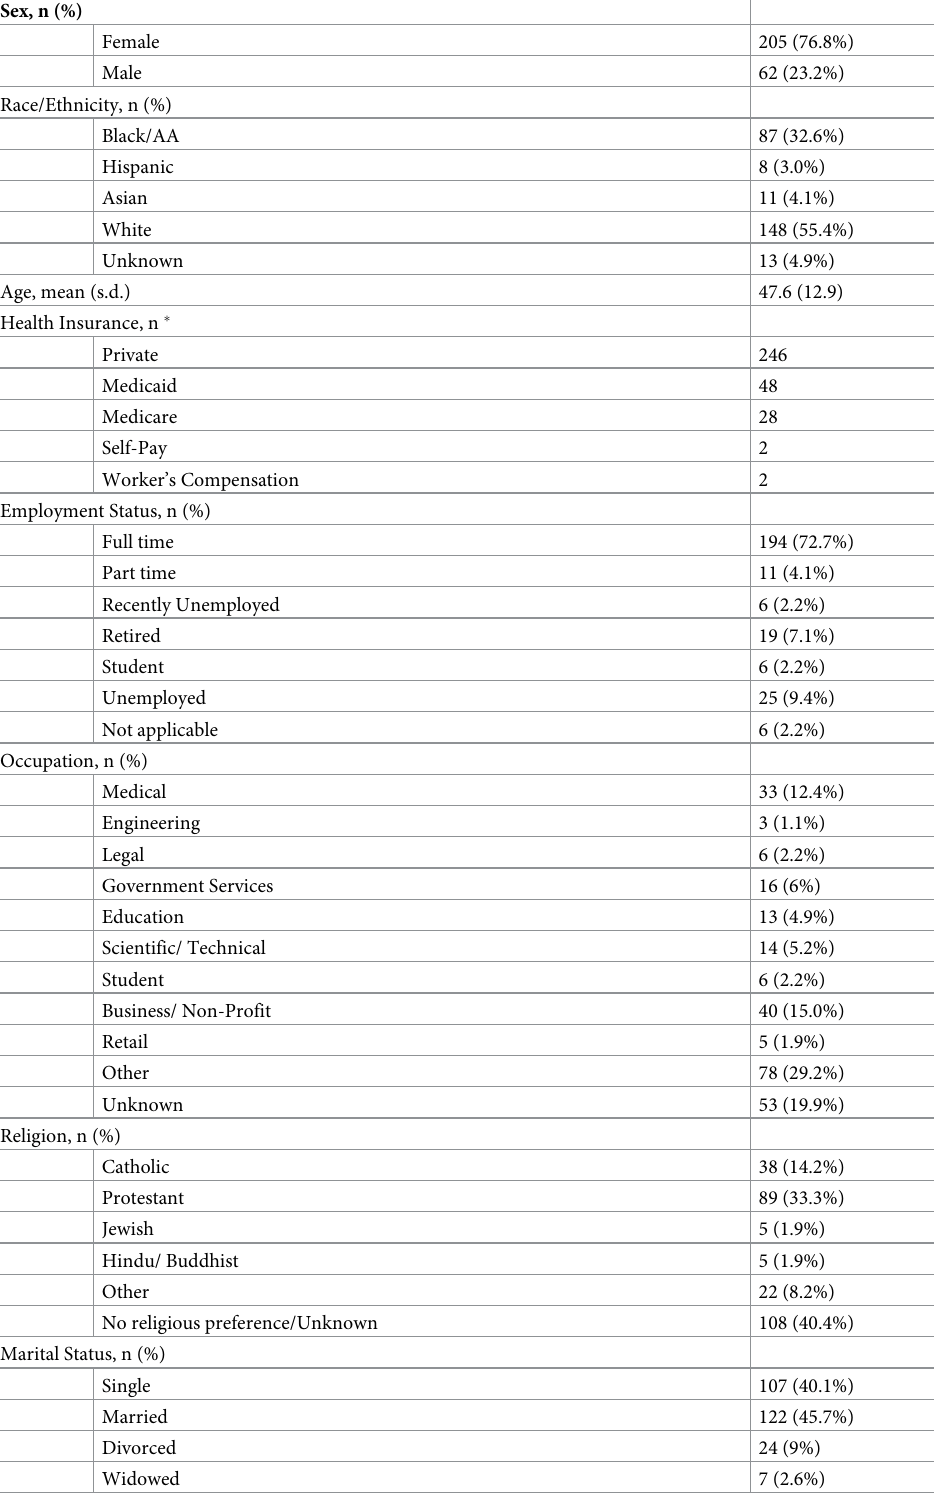
Table 1. Patient demographics (n =